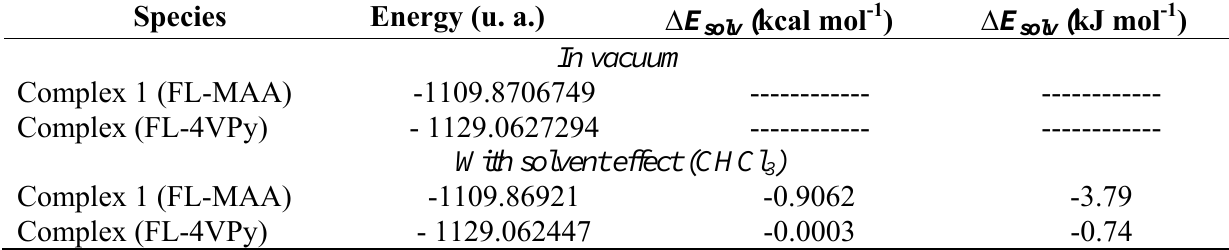
solvent. The solvent 3